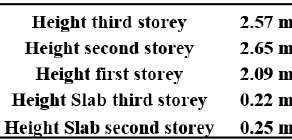
Table 7. Height of level and slab of the building.